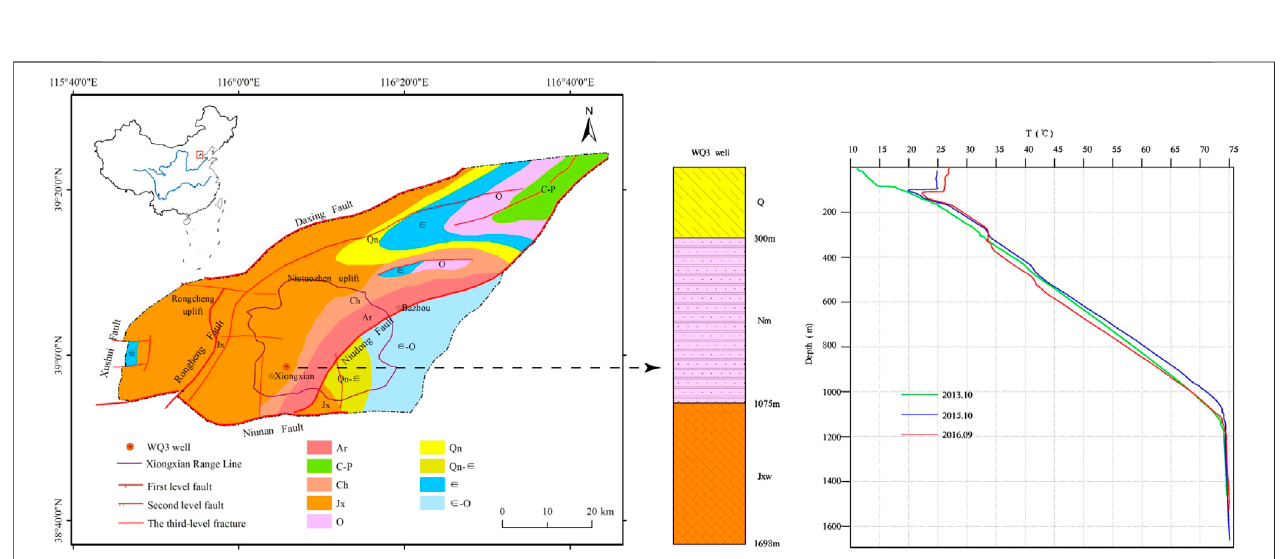
FIGURE 4 | Pre-Cenozoic geological map in the Niutuozhen uplift; the location and temperature pro fi le of monitoring well in the Xiongxian geothermal fi eld (C-P: Carboniferous – Permian; O: Ordovician; Ch: Changcheng system; Qn: Qingbaikou system; Jx: Jixian; ∈ : Cambrian; Q-Quaternary; Nm-Neogene minghuazhen group; Jxw-Jixian wumishan group) [adapted by Pang et al.